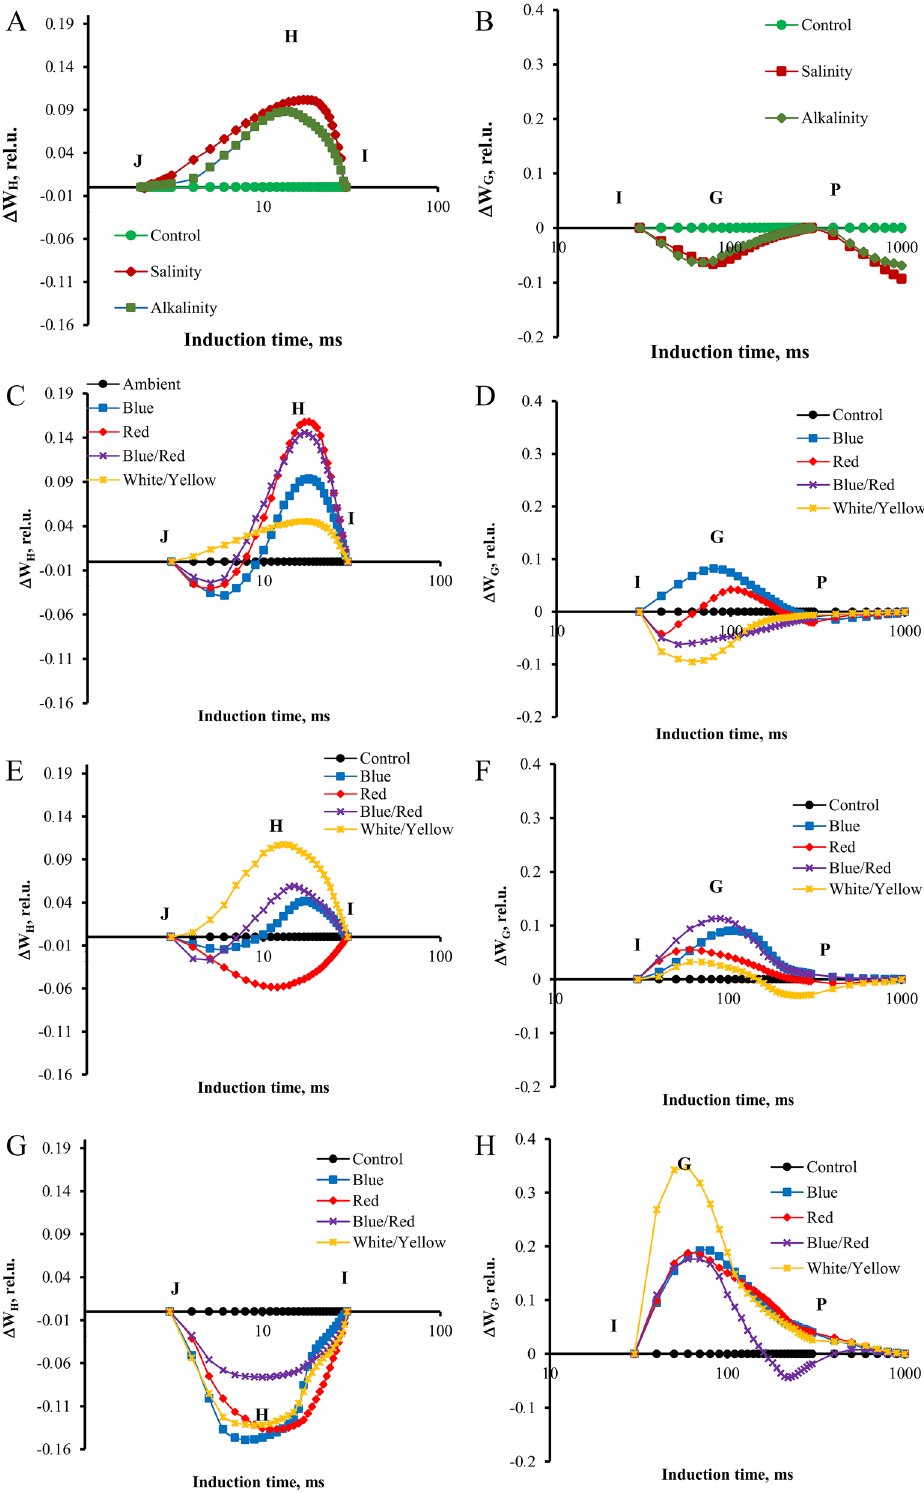
Figure 5. Differential curves of ΔW H and ΔW G of chlorophyll a fluorescence of strawberry cv. Paros. ( A,B ) In ambient light (control, salt stress, alkalinity stress); ( C,D ) non-stressed in different light spectra (ambient, blue, red, blue/red, white/yellow); ( E,F ) under salt stress in different light spectra (ambient, blue, red, blue/red, white/ yellow); ( G,H ) under alkalinity stress in different light spectra (ambient, blue, red, blue/red, white/yellow). Biophysical parameters were determined with "PEA Plus" software version 1.12 (http:// www. hansa tech- instr uments. com). The graphs were drawn using Microsoft Excel version 2016 (https:// www. micro soft.